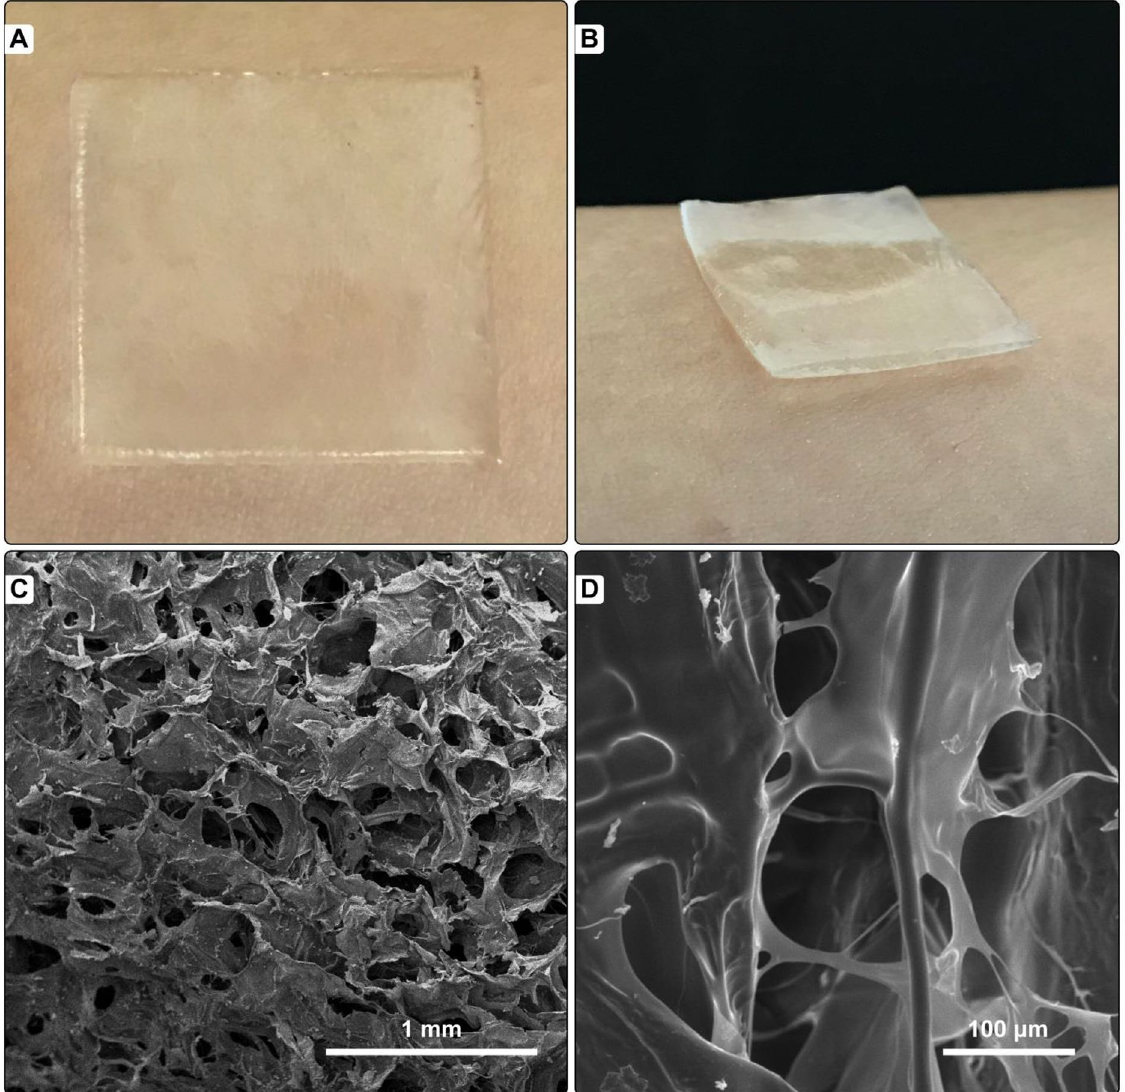
Figure 2. ( A ) and ( B ) The uniform, soft, and semi-opaque Alg-Fib@Nis-EDTA hydrogel. ( C ) and ( D ) Scanning electron microscopy of Alg-Fib@Nis-EDTA hydrogel with ( C ) 1 mm and ( D ) 100 µm scale